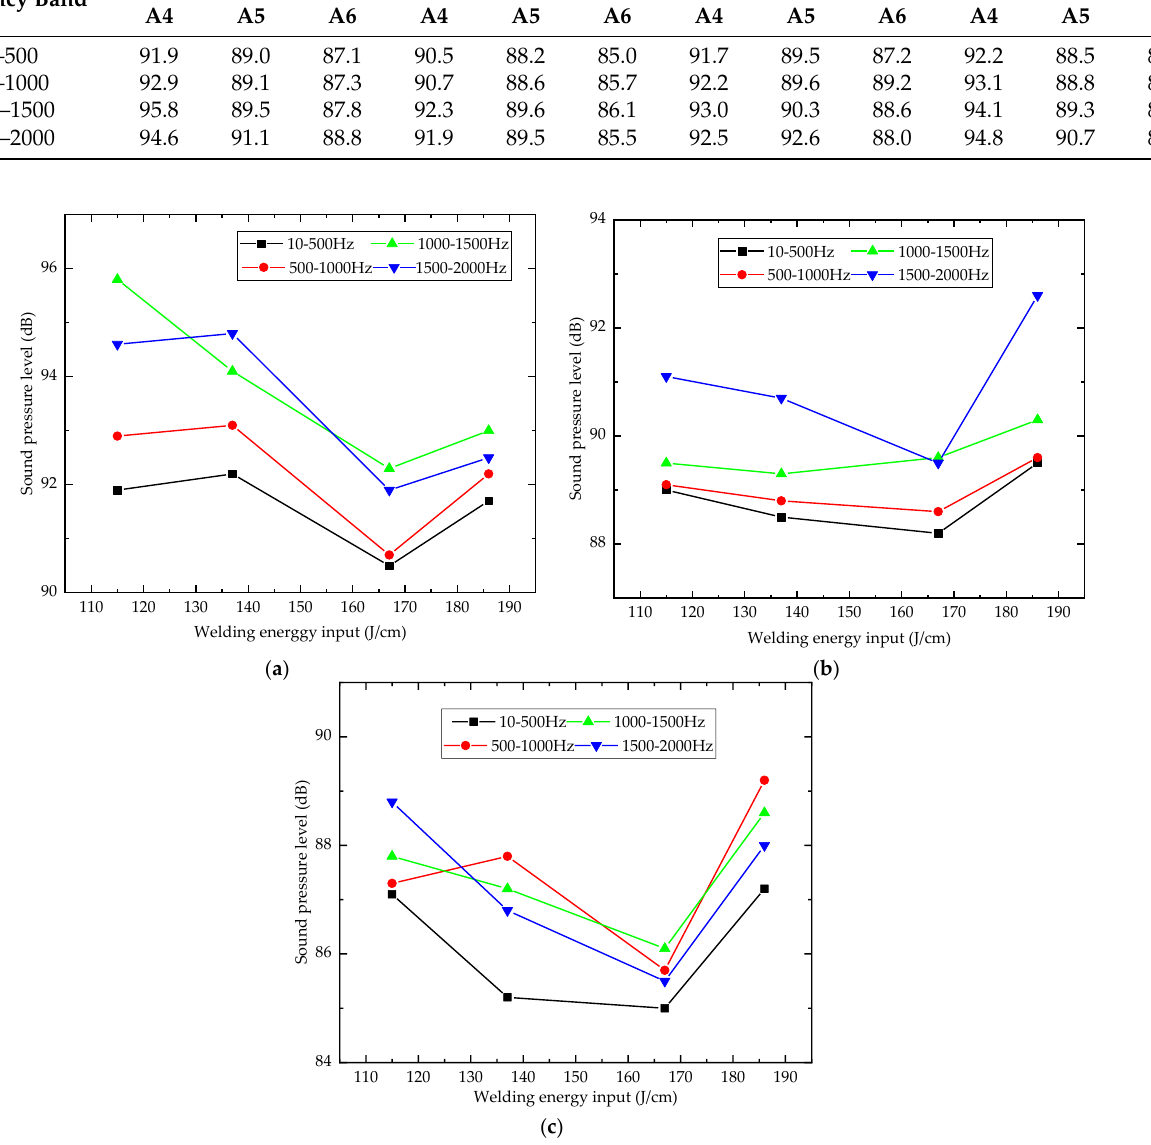
Figure 13. Influence of welding energy input on sound pressure level at different measuring points. ( a ) Measuring point A1; ( b ) measuring point A2; ( c ) measuring point